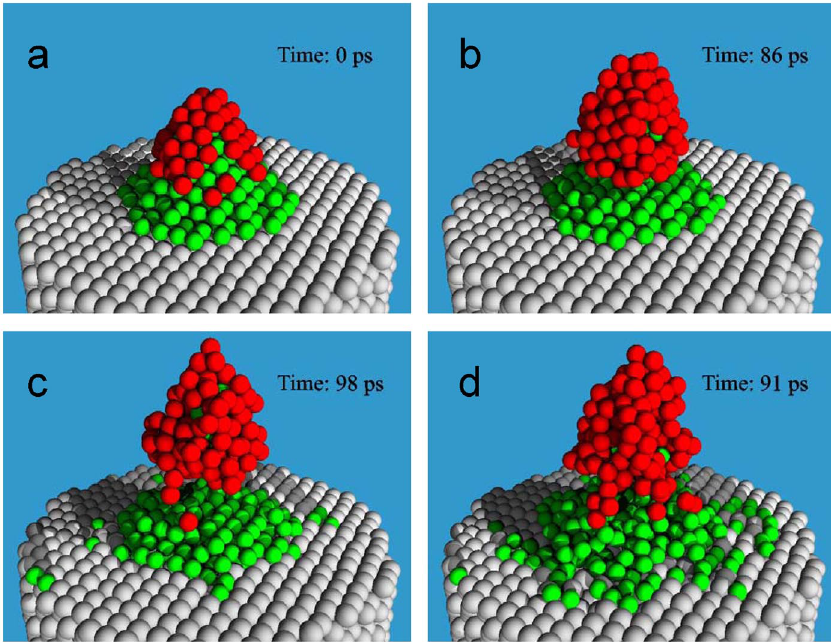
FIG. 1. (Color) (a) Initial view of a Cu tip. Red: ions; green: neutral tip atoms; gray: the atoms of a Cu (100) surface that have no (cid:1) 10 GV = m , frequency of f (cid:1) 1 : 25 GHz , at T (cid:1) 545 K . (c) 10 GV = m , electric charge. (b) Cu tip after 100 ps, in rf field of E m T (cid:1) 990 K , and 1.25 GHz. (d) Cu tip for 10 GV = m , 1.25 GHz, at temperature of 1300 K. Time instants are shown in